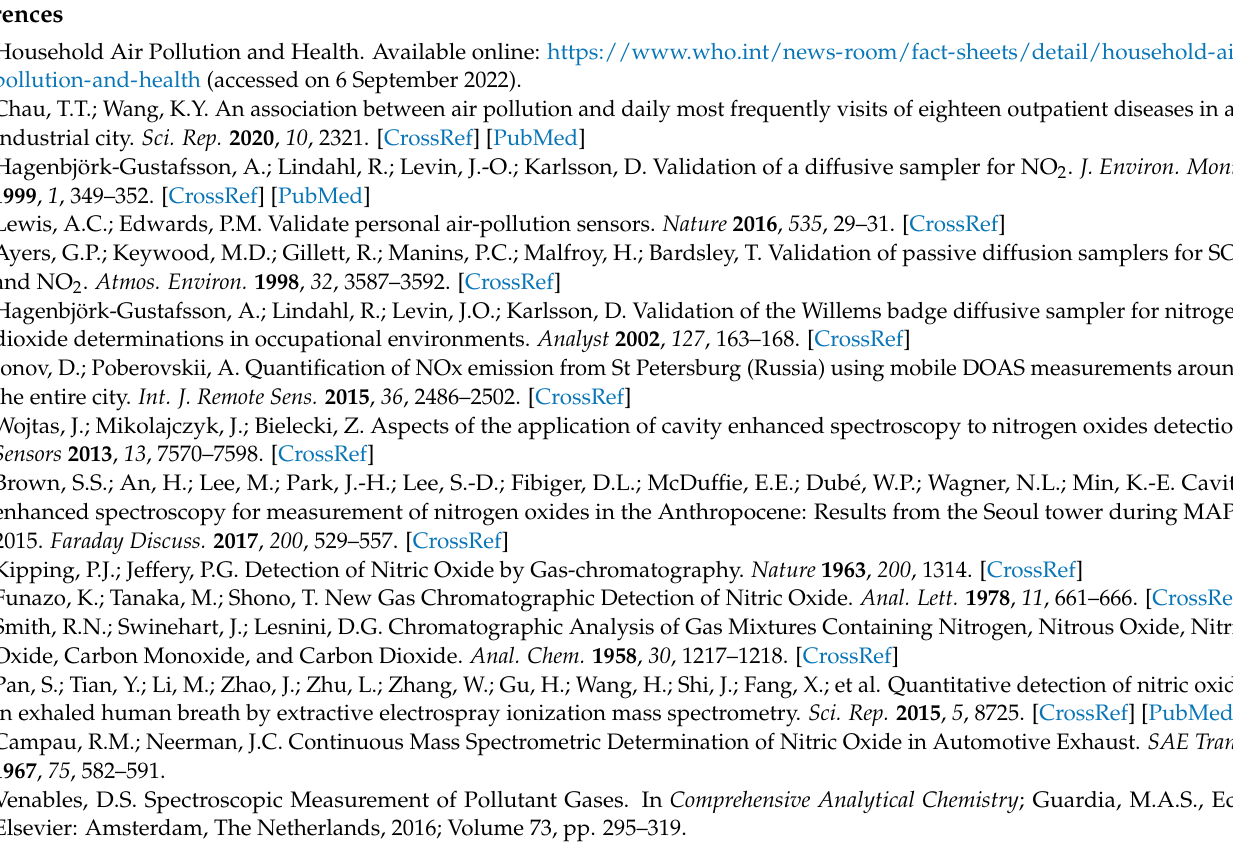
efficients for Figure S6; Table S3: Coefficients for Figure 8b; Table S4: Coefficients for Figure 9a; Table S5: Coefficients for Figure